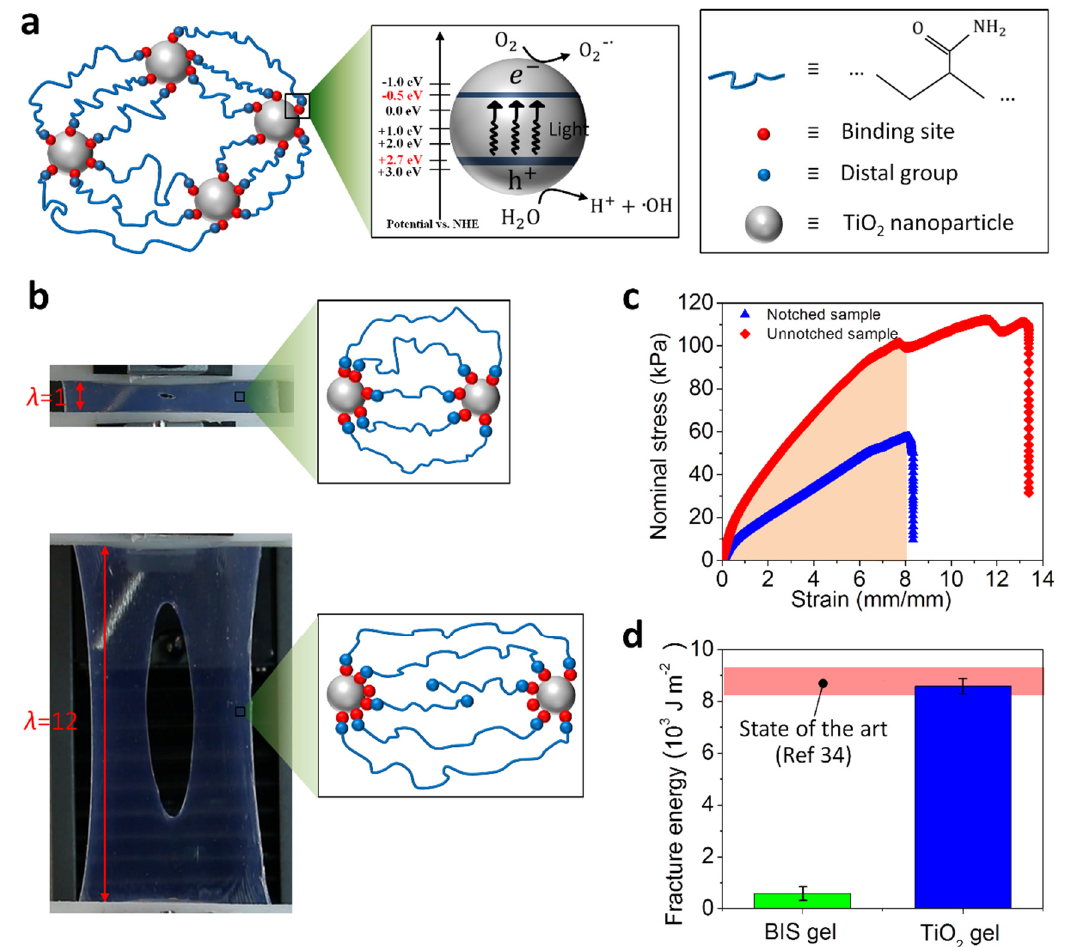
Figure 1. ( a ) A schematic to show the polymer chain network of the TiO 2 nanocomposite hydrogel and the related light ‐ triggered catalyzing mechanism of the TiO 2 nanoparticles. ( b ) Stretching of a TiO 2 nanocomposite hydrogel sample with a small crack. The stretch, λ , represented the length of the deformed sample divided by the length of the undeformed sample. ( c ) Stress ‐ strain behaviors of the notched and unnotched samples for a pure ‐ shear test to measure the fracture energy of the TiO 2 nanocomposite hydrogel. ( d ) The fracture energy of the TiO 2 nanocomposite hydrogel and a hydrogel